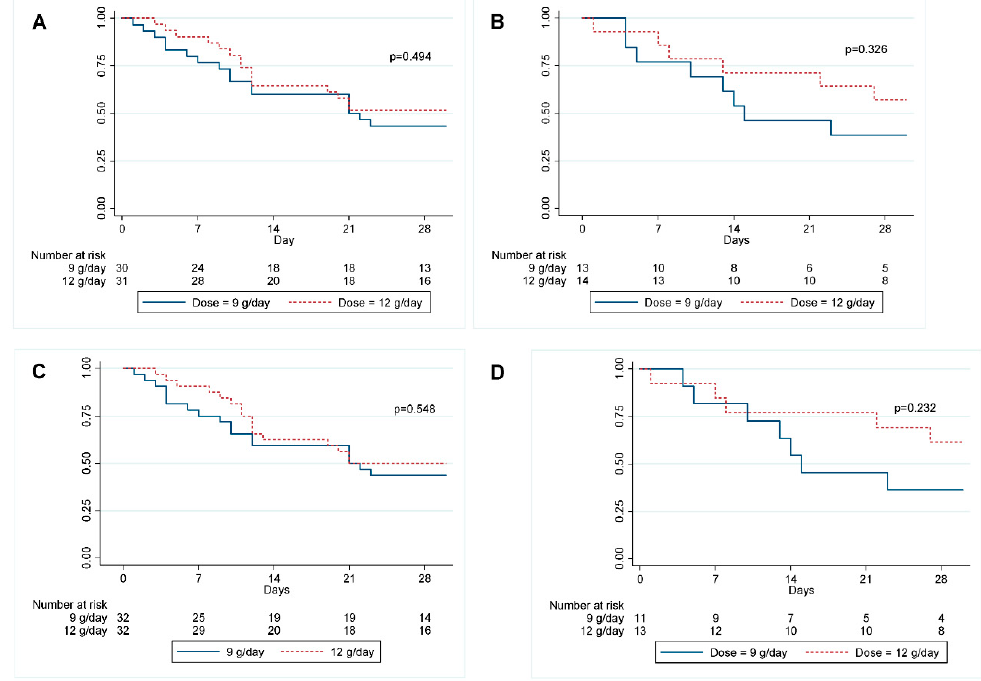
Figure 5. Kaplan–Meier survival curves for 28-day mortality of XDRAB pneumonia patients in relation to dose with subgroup analysis of MIC of sulbactam. ( A ) MIC of sulbactam ≤ 48 mcg/mL, ( B ) MIC of sulbactam > 48 mcg/mL ( C ) MIC of sulbactam ≤ 96 mcg/mL, ( D ) MIC of sulbactam > 96 mcg/mL. Table 3. Length of hospital stay, number of ventilator days and ICU days, and microbiological cure. Colistin/Sulbactam 9 g/Day Colistin/Sulbactam 12 g/Day p -Value